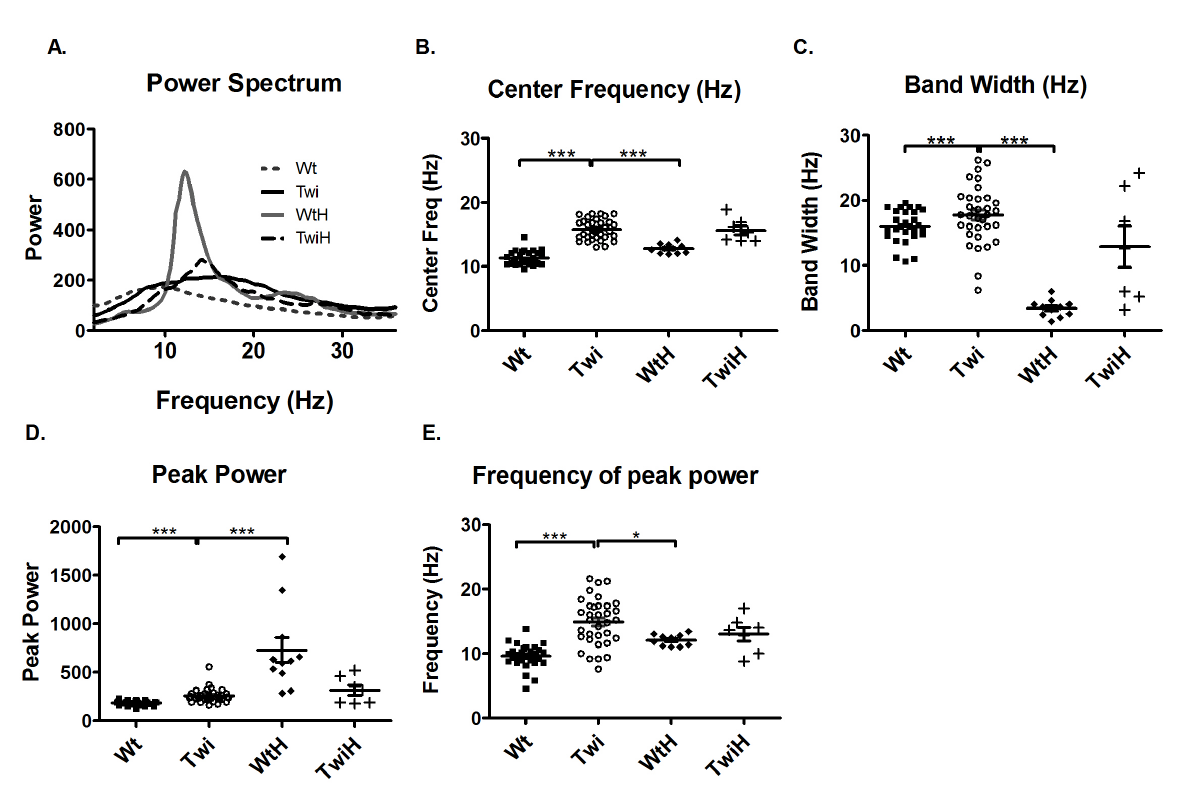
Figure 3. Comparison of the tremor of the Twi mice with that of the tremor induced by harmaline. The average power spectrum ( A ) of the Twi mice (solid black line) reflected a broadband tremor and that of the WtH mice (solid gray line) showed a characteristic narrow band 12 Hz tremor. The response to harmaline was blunted in the TwiH mice (dashed black line). The center frequency ( B ) and bandwidth ( C ) were significantly increased in the Twi group (open circles) compared to the WtH group (filled diamonds), which exhibited the expected characteristic narrow band tremor typically induced by harmaline in mice. The peak power ( D ) was significantly increased in the WtH group compared to the Twi group. The frequency at peak power was significantly decreased in the WtH group compared to the Twi group. There was no significant difference in the center frequency, bandwidth, peak power and the frequency of peak power between the Twi and TwiH groups (plus symbols). Horizontal bars represent the mean and the error bars represent the SEM (*** p < 0.001, ** p < 0.01 and * p <